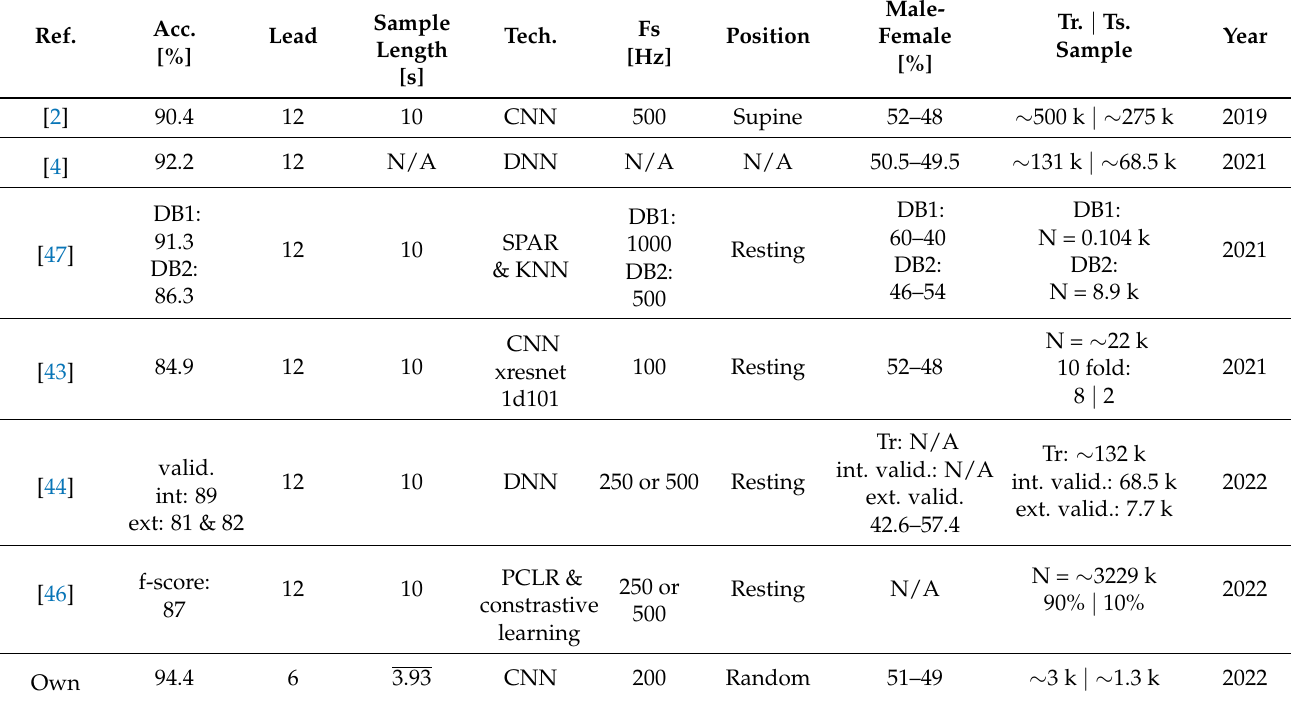
Table 1. Related work about ECG sex identification with ML